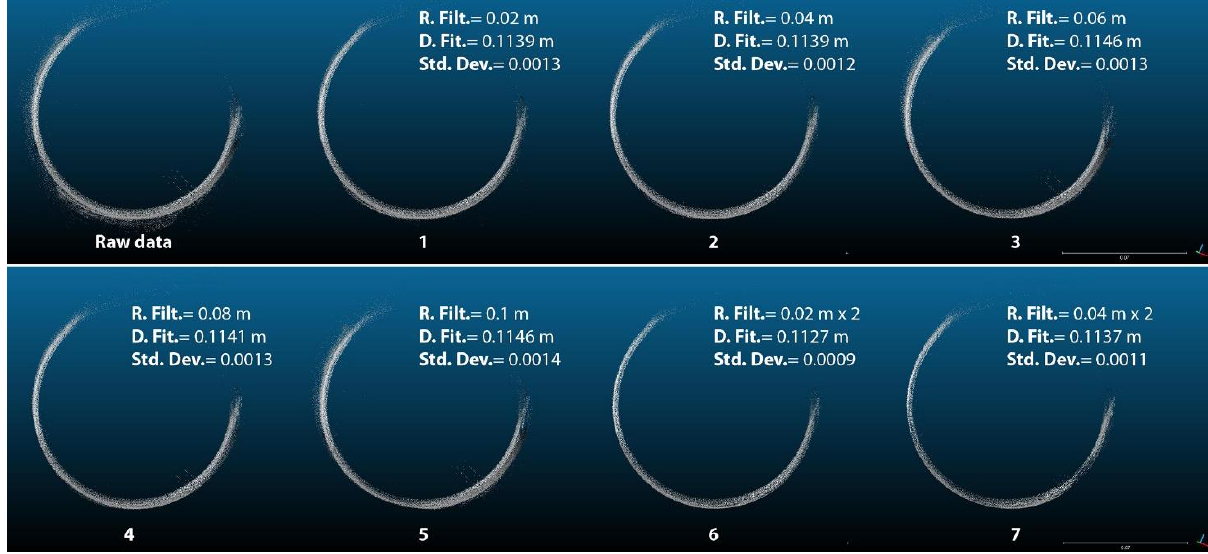
Figure 9: Comparison between different filtering levels on the same point cloud.